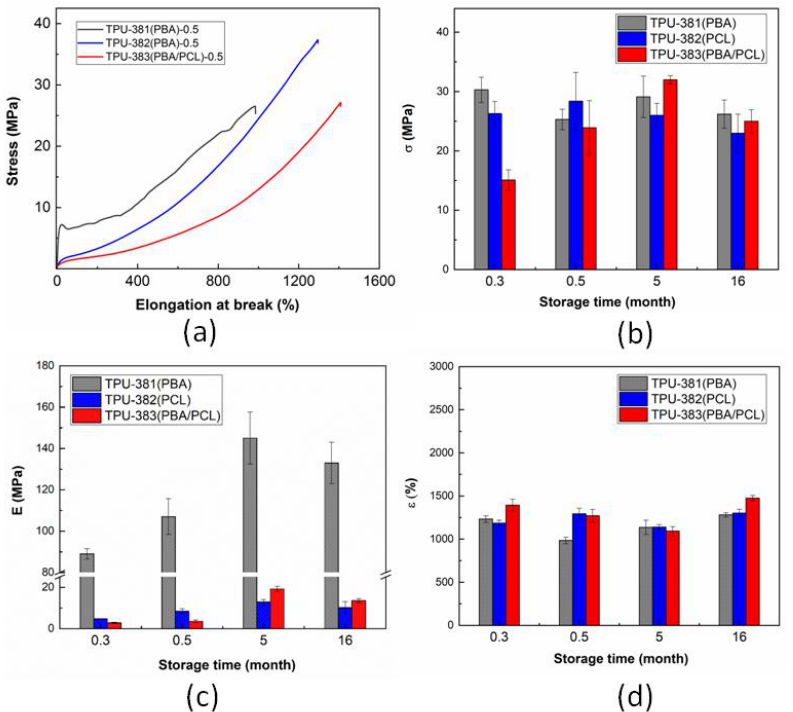
Figure 1. Stress–strain curves of the studied TPUs ( a ) and tensile strength ( b ), Young’s modulus ( c ), and elongation at break ( d ) as a function of storage time for TPUs with different compositions of soft segments.